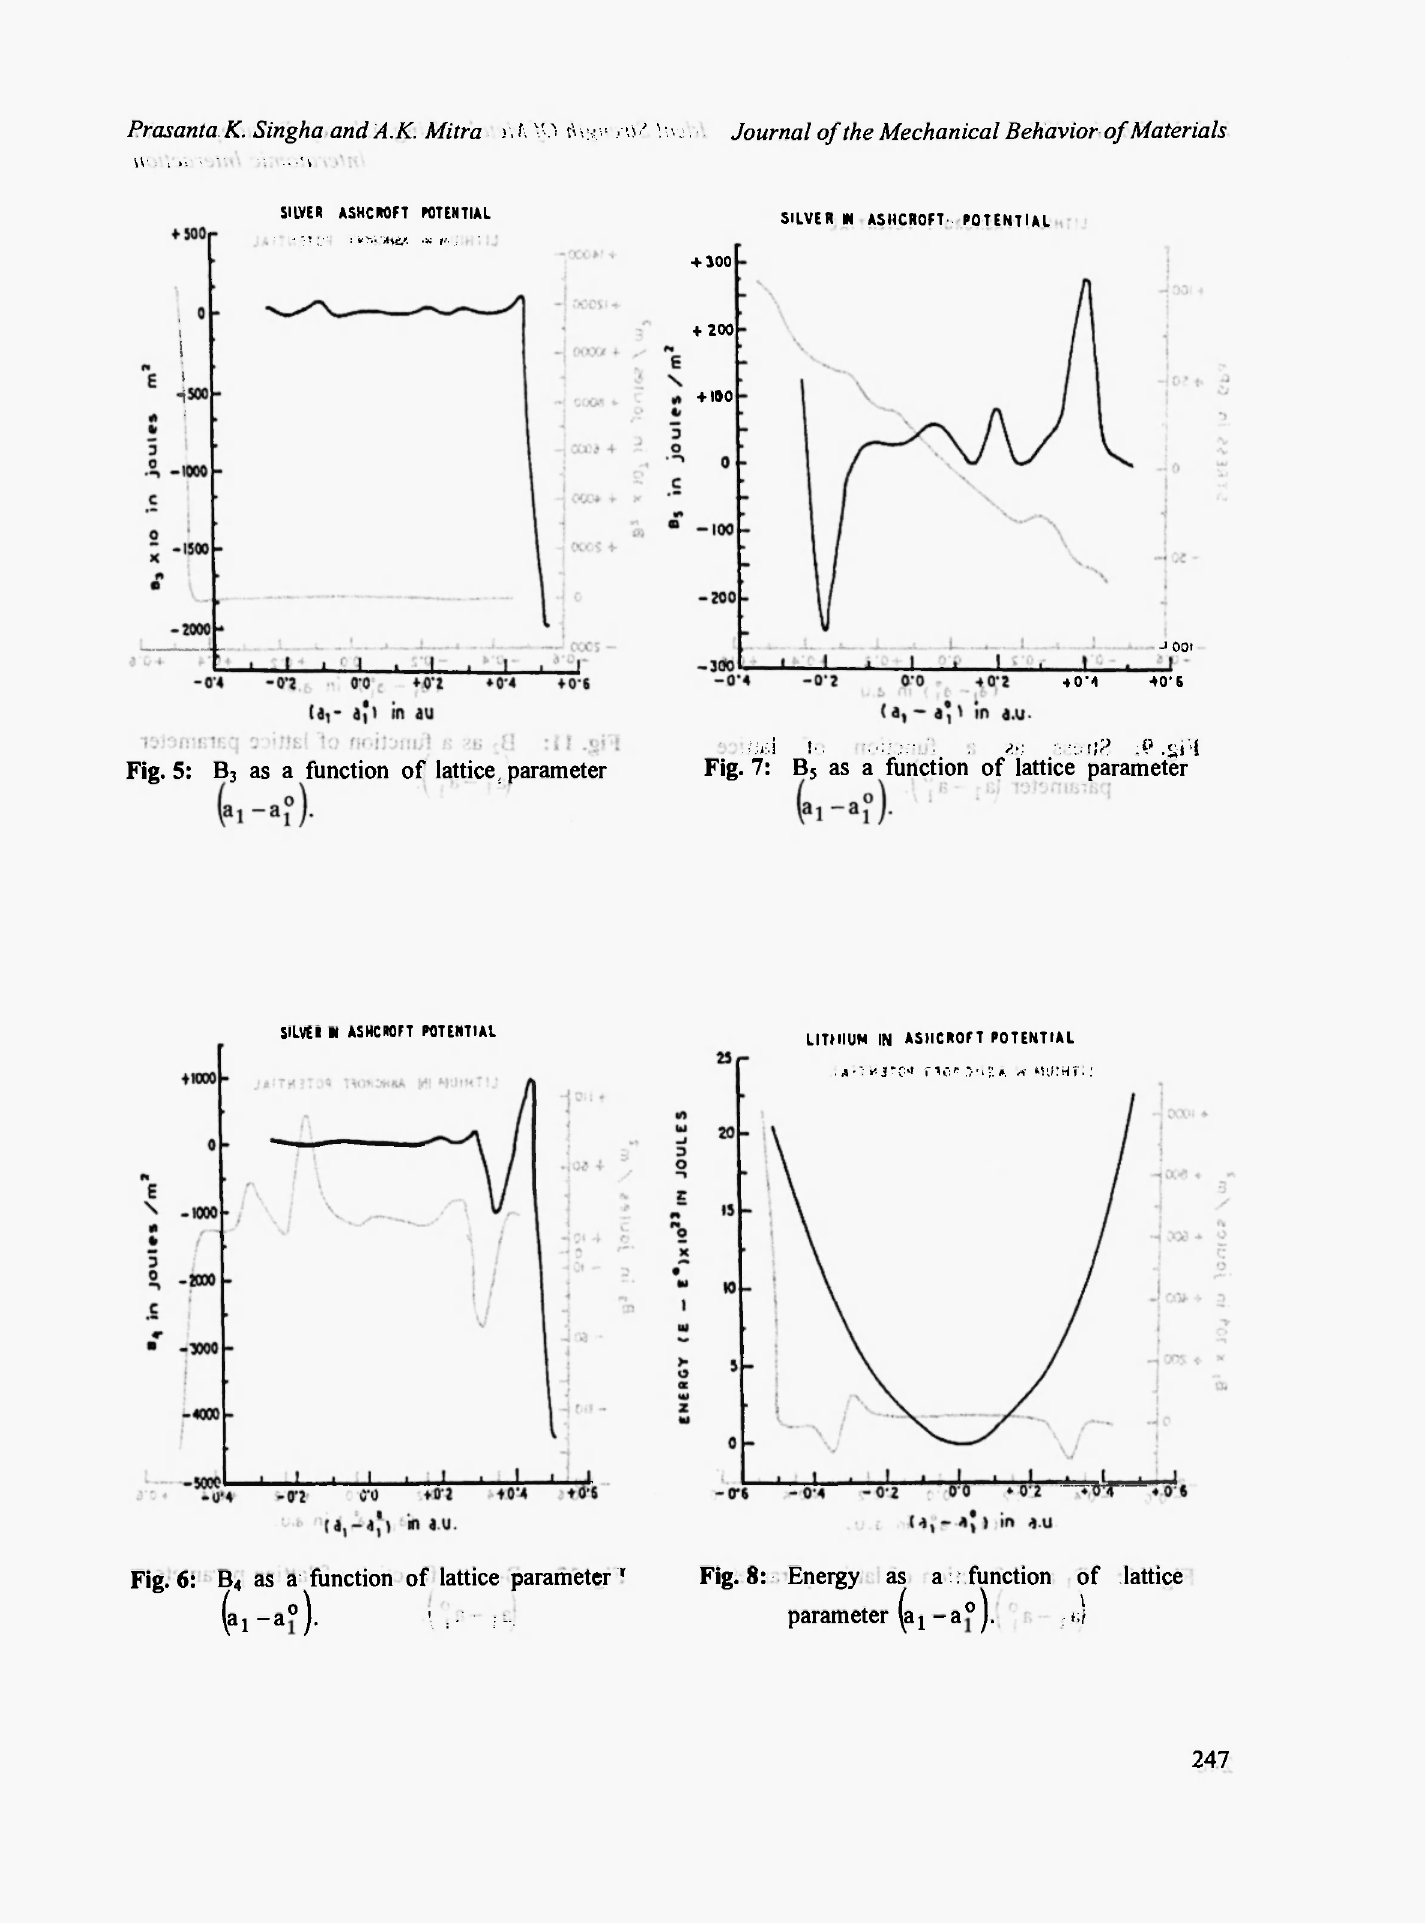
Fig. 6: B 4 as a function of lattice parameter Fig. 8: Energy as a function of lattice ( a i - a °